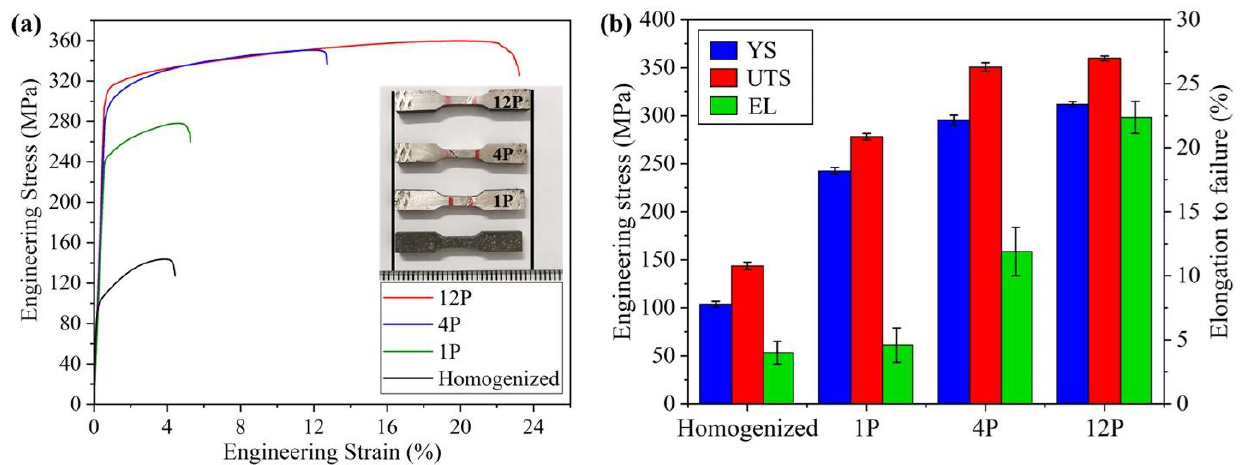
Figure 10. ( a ) Engineering stress–strain curves of GW103 samples after different processing condi- tions; ( b ) the corresponding mechanical properties: yield stress (YS), ultimate tensile strength (UTS) and elongation to failure (EL).